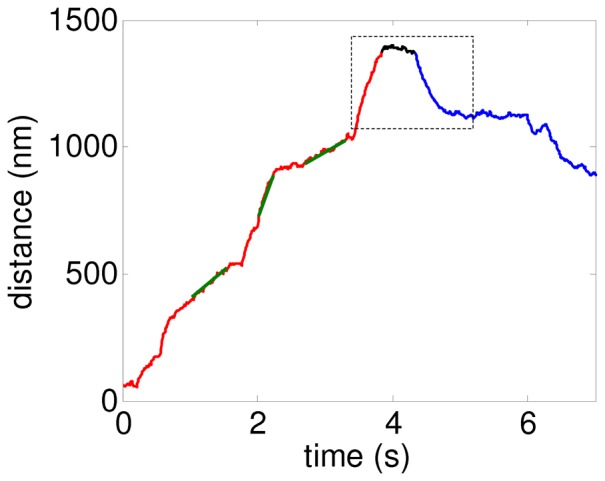
Trajectories and segments.Representative trajectory of a cargo obtained during a simulation of the model with Nf = Nb = 2 showing a processive trend in the forward direction (red trace) followed by a reversion (dashed rectangle) and, finally, a motion in the backward direction (blue trace). Segmental velocities are determined from pieces of the trajectory containing 40 data points during which the cargo moves with constant velocity, such as the ones indicated with green traces. The system is symmetric and the corresponding parameters are displayed in Table 1.